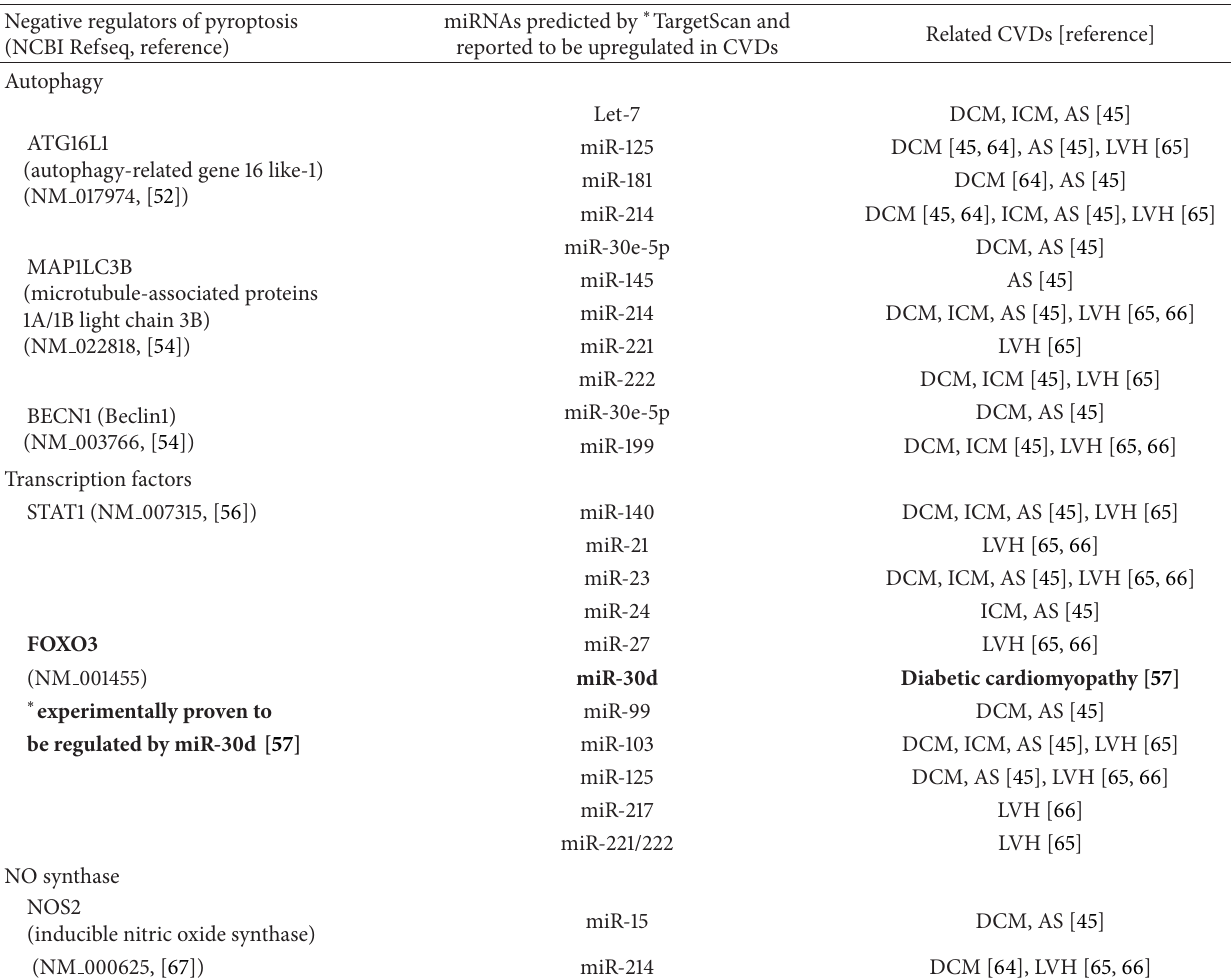
Table 3: Selected examples of miRNAs targeting human negative regulators of pyroptosis and reported to be increased in CVDs. Negative regulators of